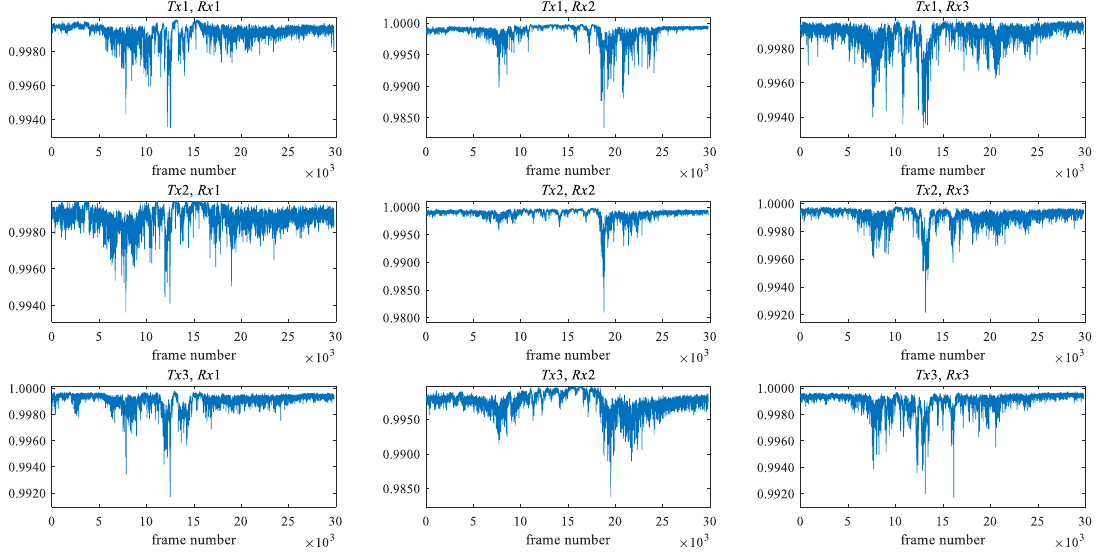
Figure 3. The maximum eigenvalue characteristics of channel state information (CSI) amplitude when the low pass filter is not applied.